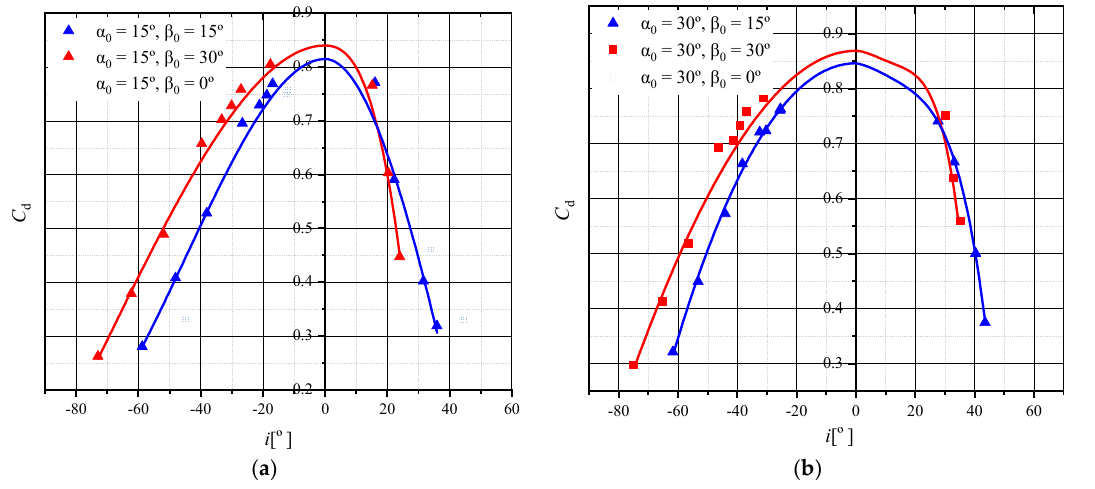
Figure 27. Relationship between C d and i under the condition of same α 0 and different β 0 . ( a ) α 0 = 15 ◦ with different β 0 ; ( b ) α 0 = 30 ◦ with different β 0